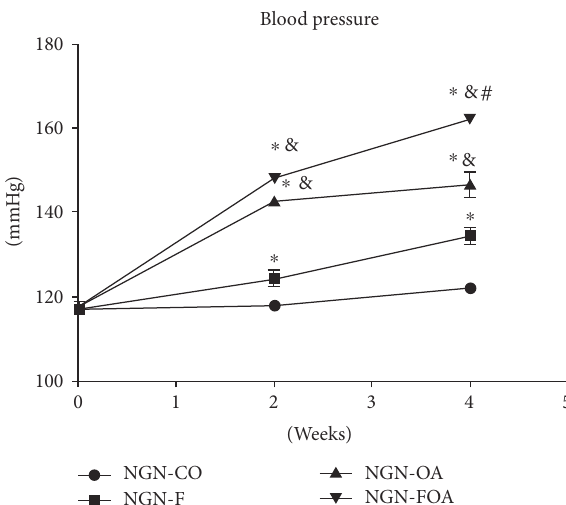
Figure 1: Blood pressure in NGN groups, basally and on the 2nd and 4th weeks after beginning of treatment. NGN (normogonadic); CO (control); F (fructose); OA (oxonic acid); FOA (fructose and oxonic acid). ∗ p < 0 001 control group versus F, OA, and FOA groups on the 2nd and 4th weeks. & p < 0 01 F group versus OA and FOA groups on the 2nd and 4th weeks. # p < 0 01 OA group versus FOA groups on the 4th week.